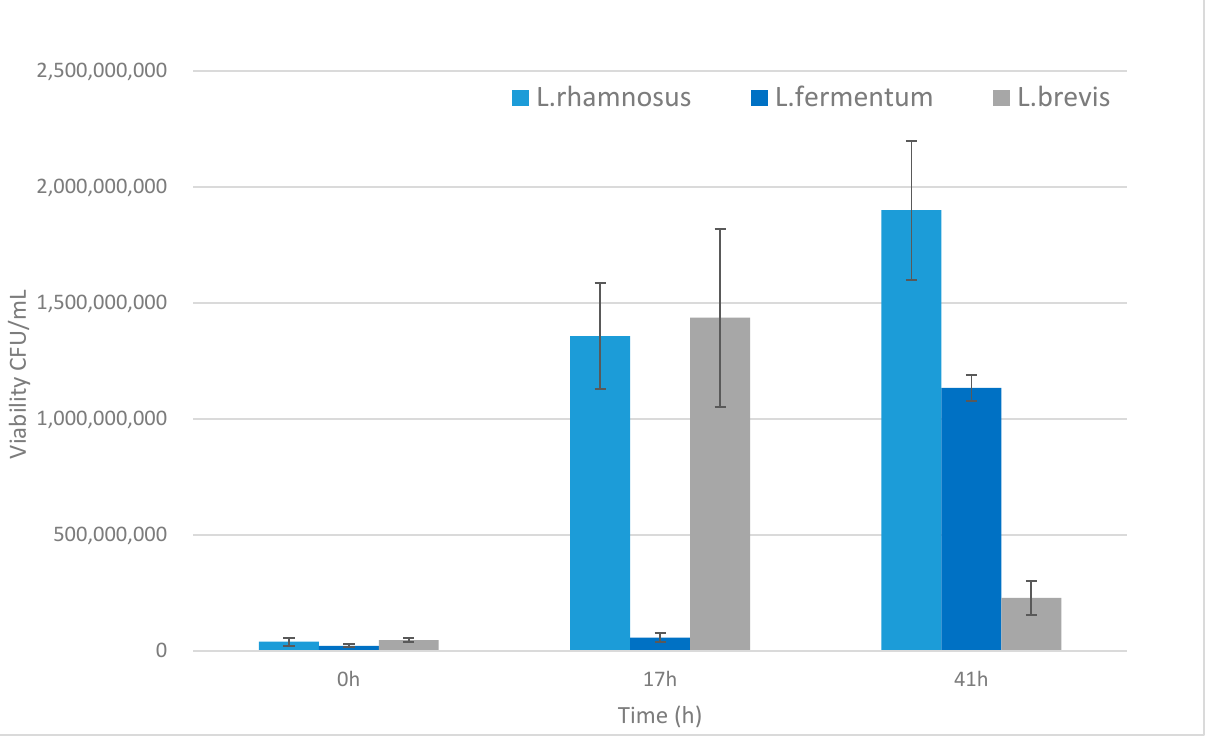
Figure 2. Growth comparison on SCW of L. rhamnosus IMC501, L. brevis SP ‐ 48 and L. fermentum . Tests on SCW fractions were performed in two series of experiments in order to identify the possible use of retentates obtained from membrane processes. The first experiments were carried out with standard sterilization of the medium at 121 °C for 20 min at 1 bar of pressure. Growth of L. rhamnosus on RNF, R10, and R100 produced 2.2 ± 0.3 × 10 9 , 9.5 ± 3 × 10 8 , and 4.9 ± 2 × 10 8 CFU/mL, respectively (Figure 3). Biomass and lactic acid production was also evaluated on pasteurized fractions, as shown in Figure 4. Experiments lasted 16 h to avoid contamination issues.